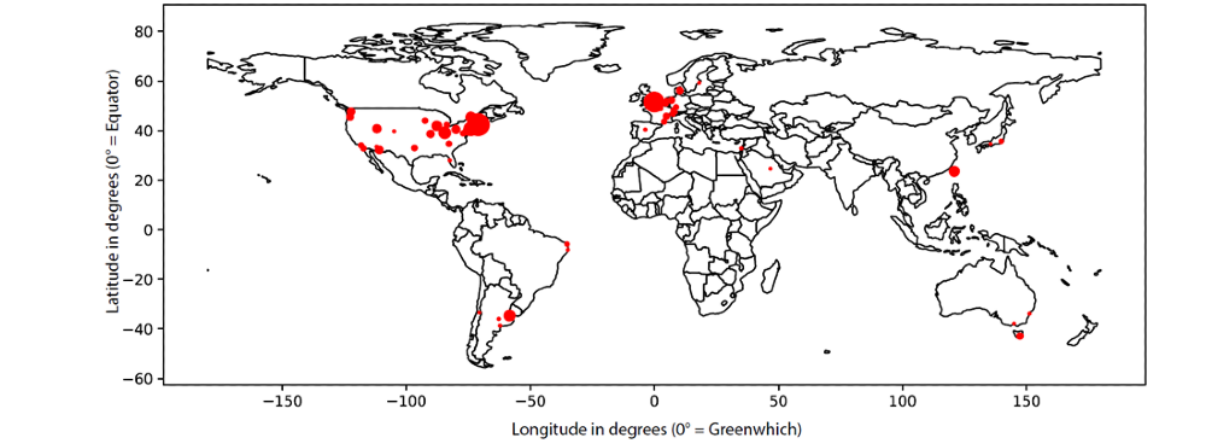
Figure 3. Geographical distribution of